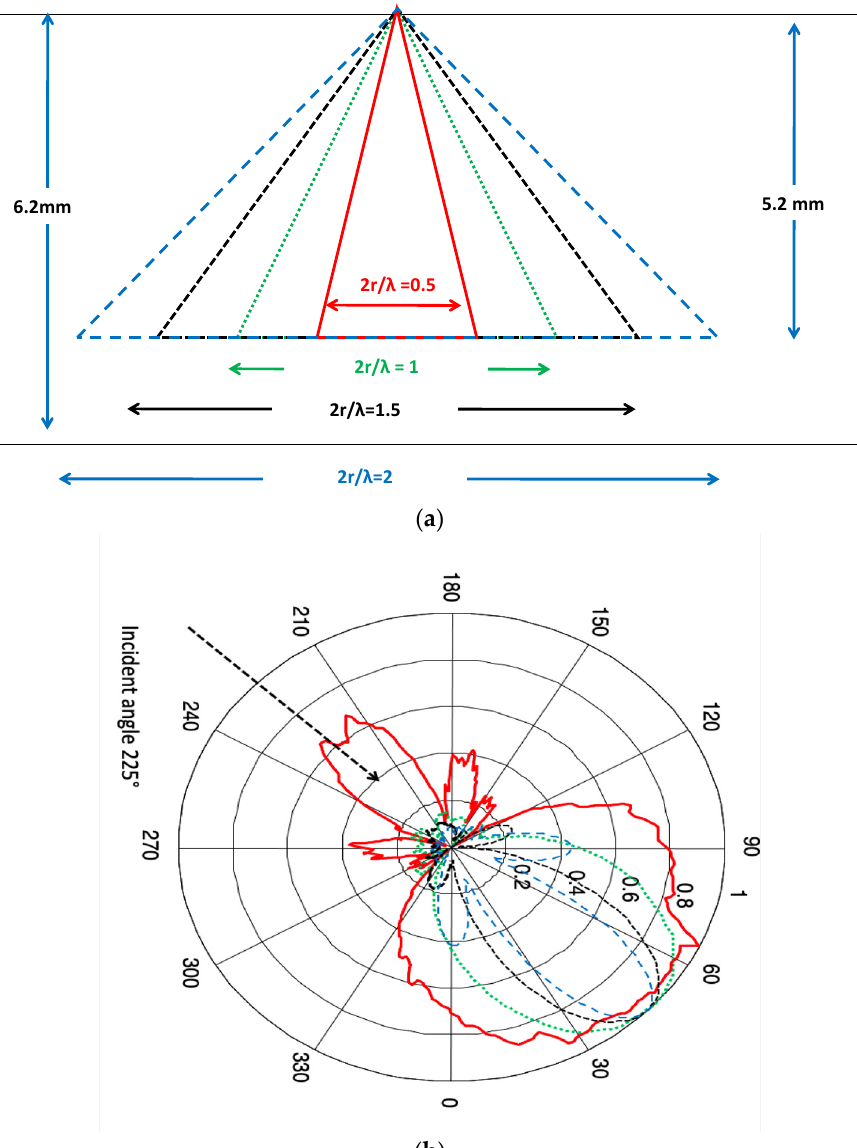
Figure 15. Effect of aspect ratios (2 r/ λ ): ( a ) Schematics for four different aspect ratios (0.5: red, 1: green, 1.5: black, 2: blue), ( b ) normalized scattered amplitude of A 0 mode.